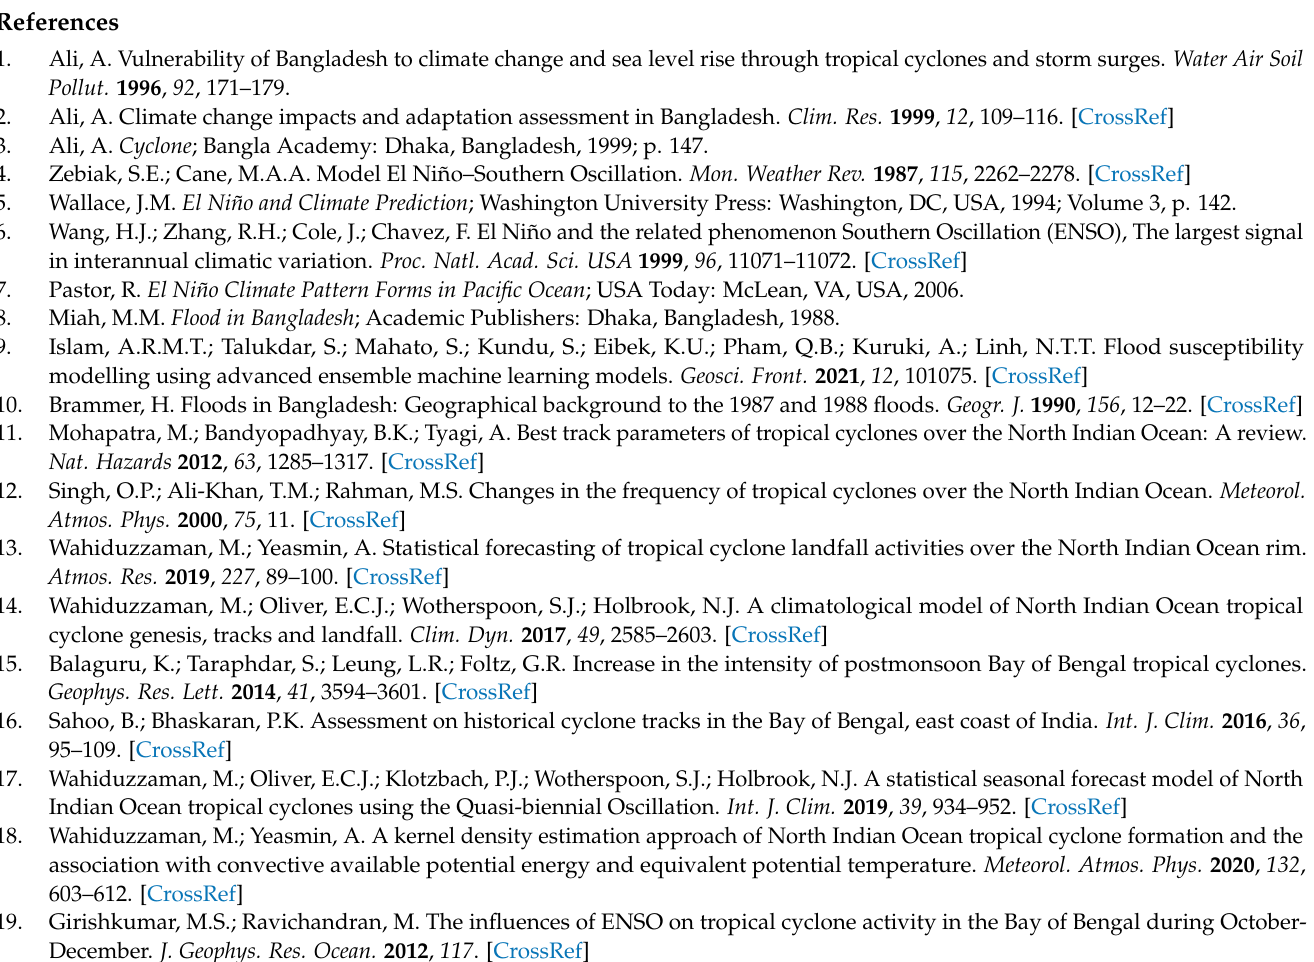
Figure 7. Frequency of excess and deficit of rainfall during monsoon under El Niño and La Niña. Four cyclones belong to La Niña condition which hit northern and north-western part of Chittagong and three cyclones belong to El Niño condition which hit southern part of Chittagong with exception of 1991 and the rest five cyclones belong to neutral ENSO. Among these five cyclones, four cyclones are found under weak La Niña and if the neutral condition is not considered then Bangladesh faces more TCs during La Niña. The re-curvature takes place in higher latitudes for those developed in El Niño than La Niña phase. Synoptic variables support the occurrence of major floods and TCs in Bangladesh under La Niña phase.